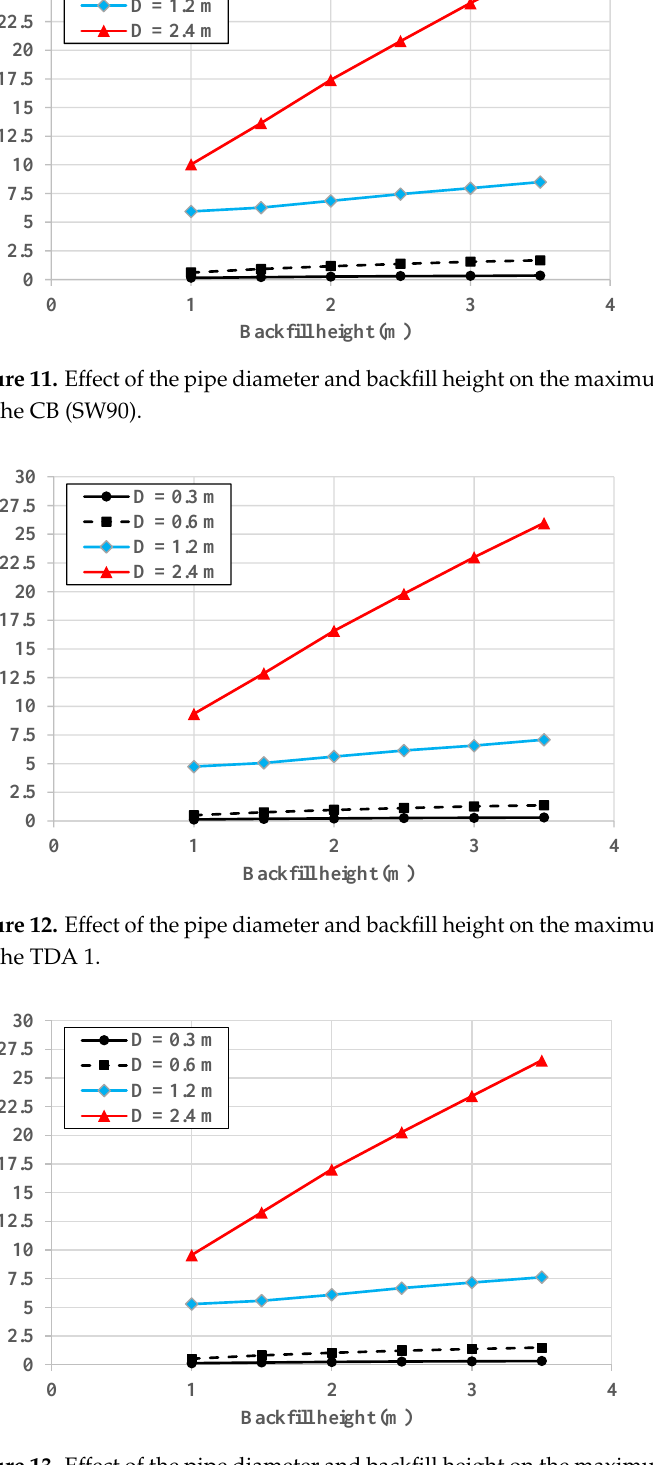
Figure 13. Effect of the pipe diameter and backfill height on the maximum pipe wall bending moment for the TDA 2.